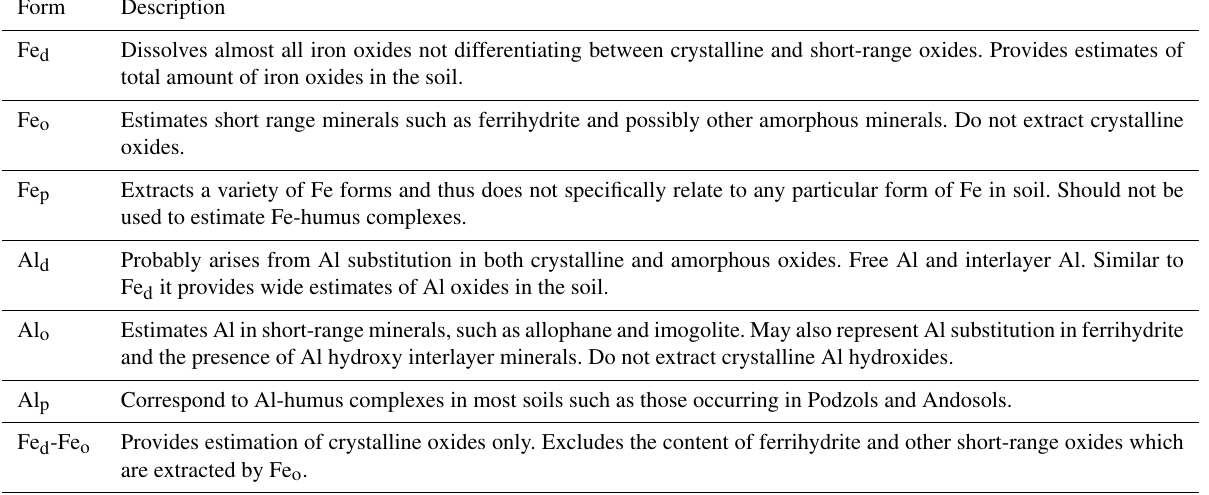
Table 2. A guide for interpretation of selective dissolution data following Parfait and Childs (1988).